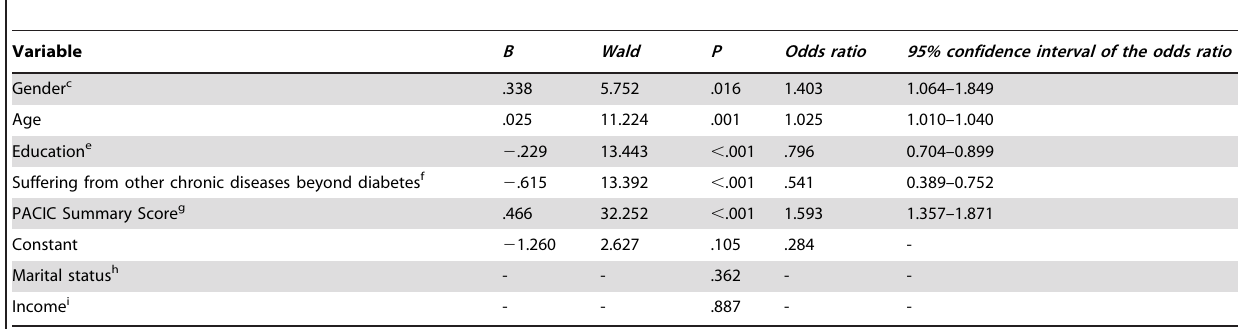
Table 5. Logistic regression analysis a including variables associated with the most often utilized medical institutions b for monitoring and treating diabetes among the patients with type 2 diabetes (N